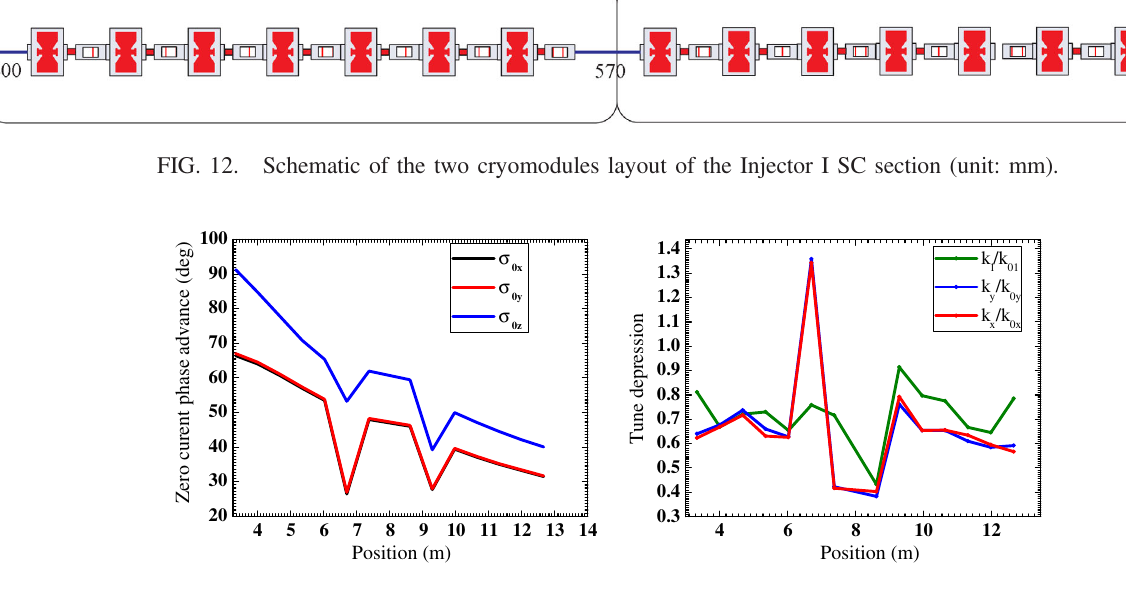
FIG. 13. Zero current phase advance of the SC section of the ADS Injector I linac (left), the tune depression along the SC section of the Injector I (right): X in red, Y in blue, and Z in green.